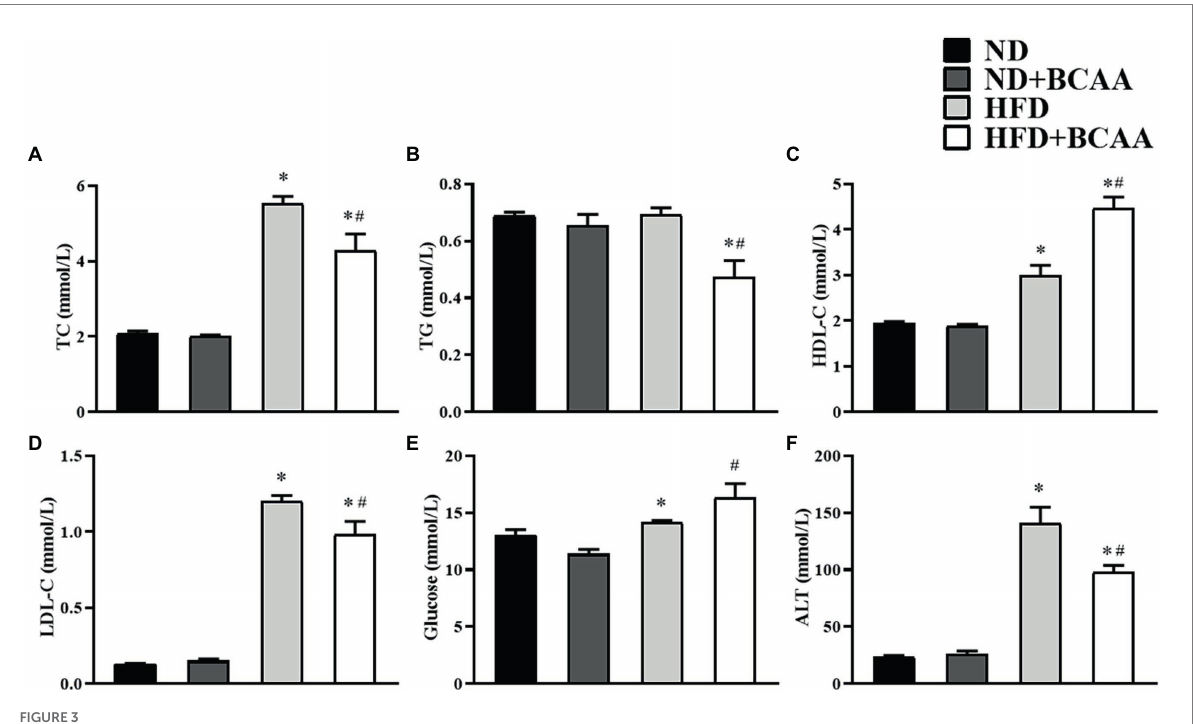
FIGURE 3 Effect of BCAAs supplementation on the blood lipid, glucose, and ALT levels in mice. The serum concentrations of (A) total cholesterol (TC), (B) triglycerides (TGs), (C) high-density lipoprotein cholesterol (HDL-C), (D) low-density lipoprotein cholesterol (LDL-C), (E) glucose, and (F) alanine aminotransferase (ALT). The data are presented as the mean ± SEM ( n = 6). * p < 0.05 vs. the ND group; # p < 0.05 vs. the HFD